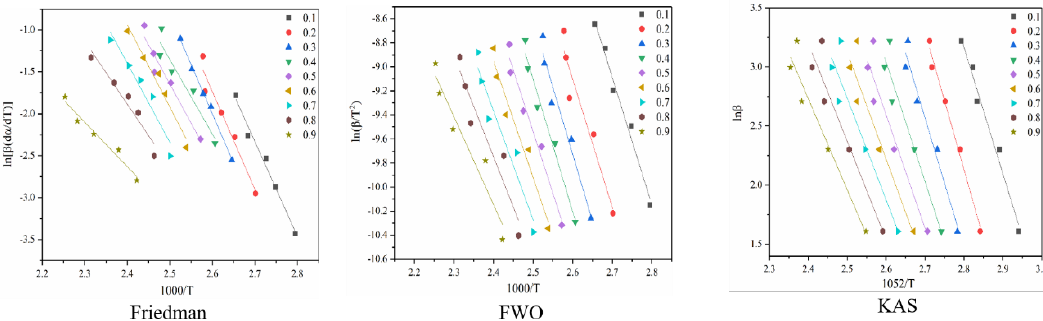
Figure 3. Conversion curves of three stages of battery material pyrolysis.